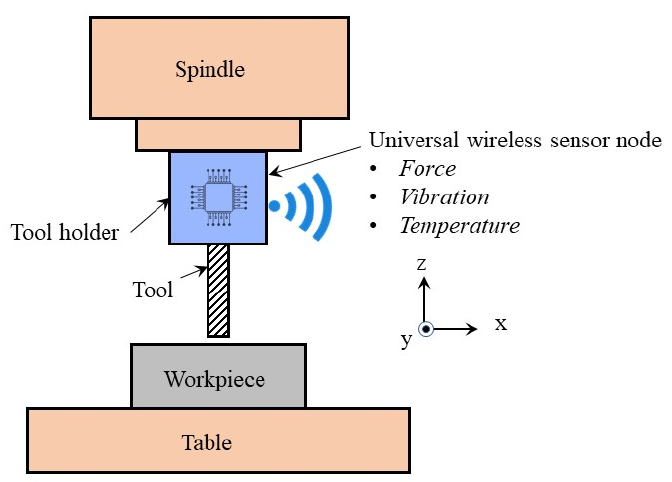
Figure 3. Wireless sensor node structure.